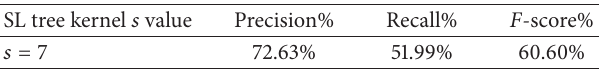
Table 3: The overall NER system performance using proposed kernel of 𝑠 = 7